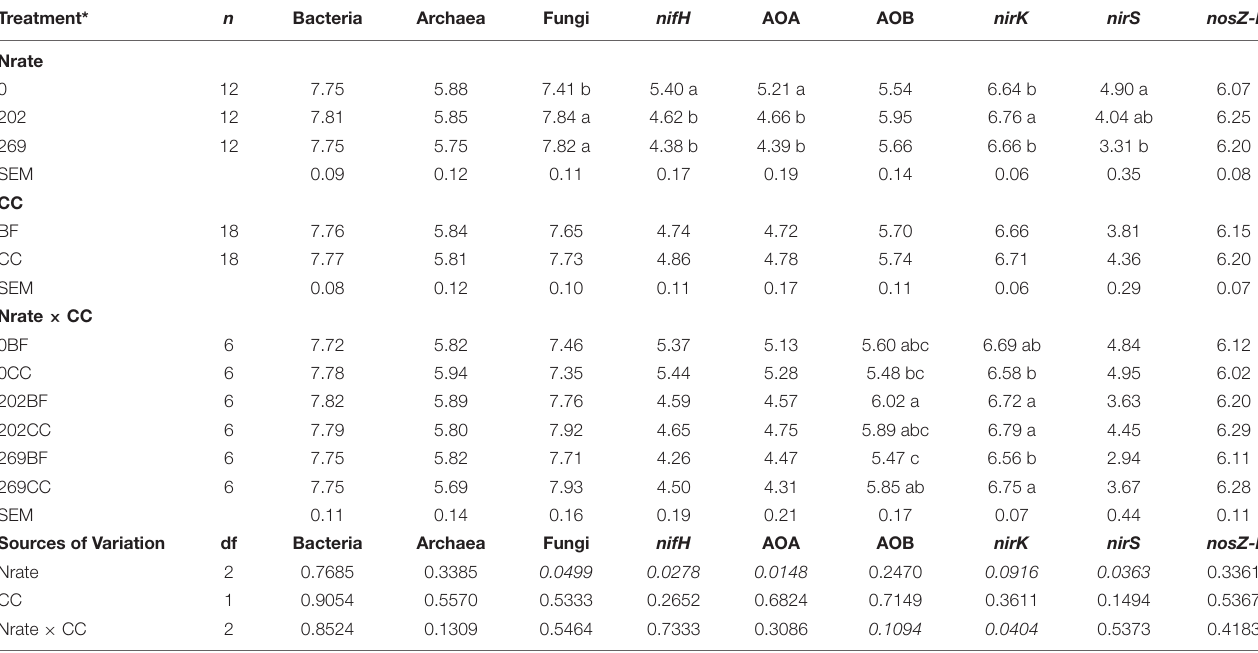
TABLE 2 | Estimated treatment means and standard errors of the mean (SEM) of the log 10 -transformed copies (per µ g DNA) of microbial marker genes, including bacterial (Bacteria) and archaeal (Archaea) 16S rRNA, fungal ITS region (Fungi), nifH , archaeal (AOA) and bacterial (AOB) amoA , nirK , nirS , and nosZ-I determined under N fertilization (Nrate), Cover crop (CC) treatments, and their